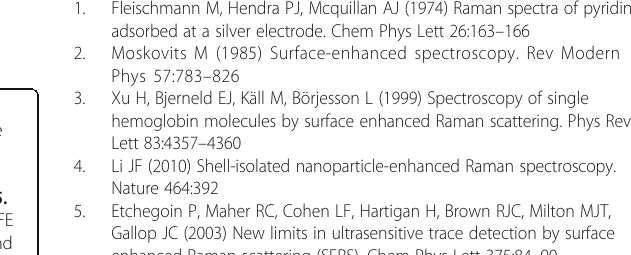
b the evaporating temperature is 20 °C; c and d the evaporating temperature is 70 °C. The whole red small boxes represent the magnified area. Figure S6. The relation between the Ag concentration and the Raman intensity. Figure S7. SERS mapping results of methylene blue at 1322 cm − 1 obtained from 1 × 10 − 9 M aqueous solutions on the original PTFE b and the engraved PTFE d. The measurement areas are circled by the homologous red square frame in the a and c. Table S1. The limit detection of MB, R6G, and BSA detected on various substrates or used different methods. (DOCX 2605